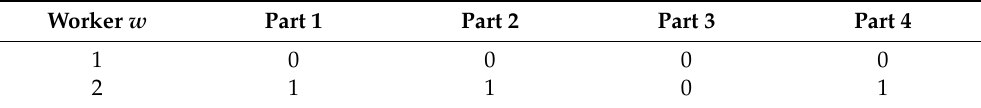
Table 9. Solution of worker-part assignment in Cell 1 obtained by using two-stage ALNS for the illustrative example.